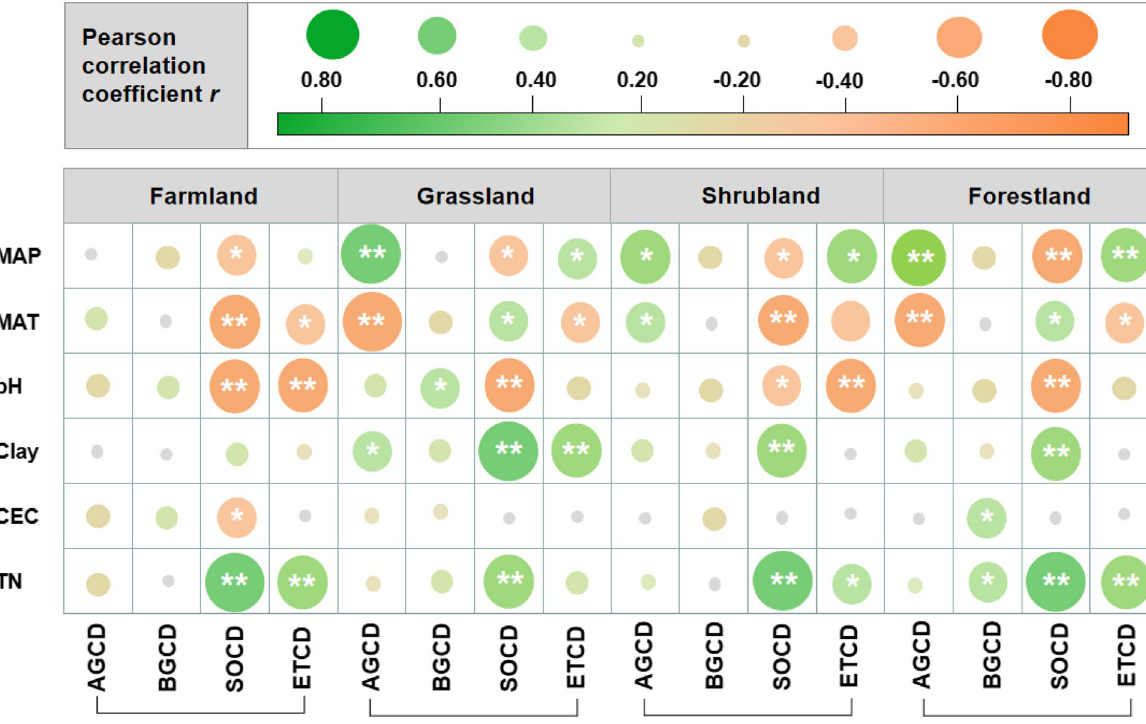
0.80); orange indicates a negative =